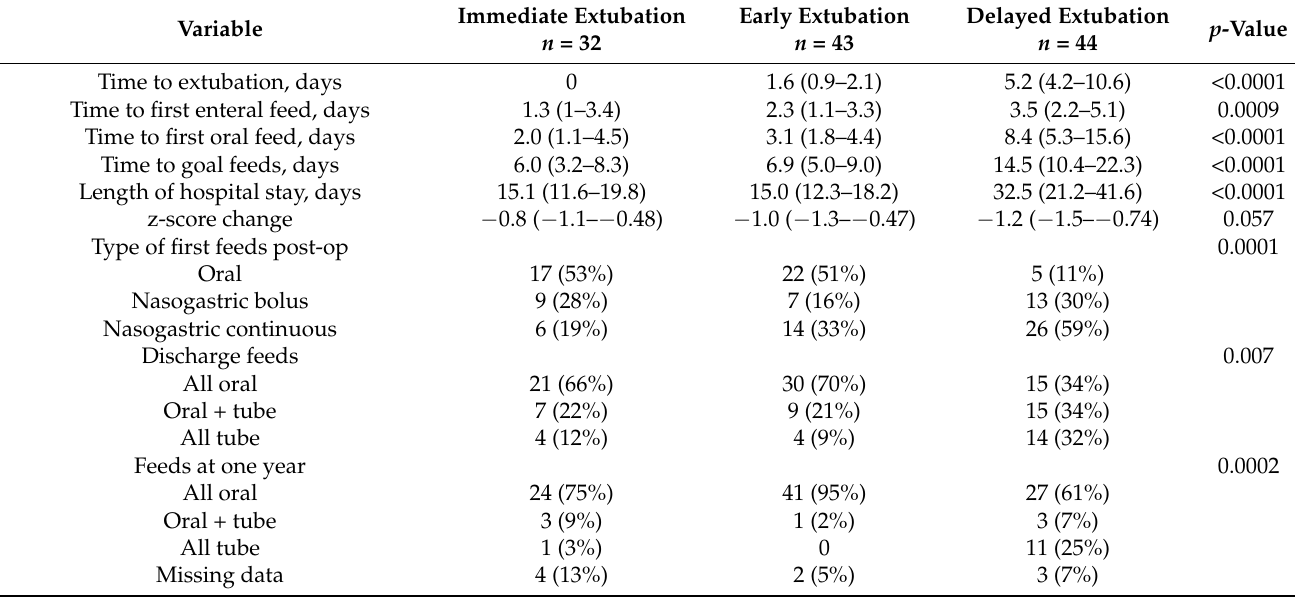
Table 2. Clinical outcomes based on timing of